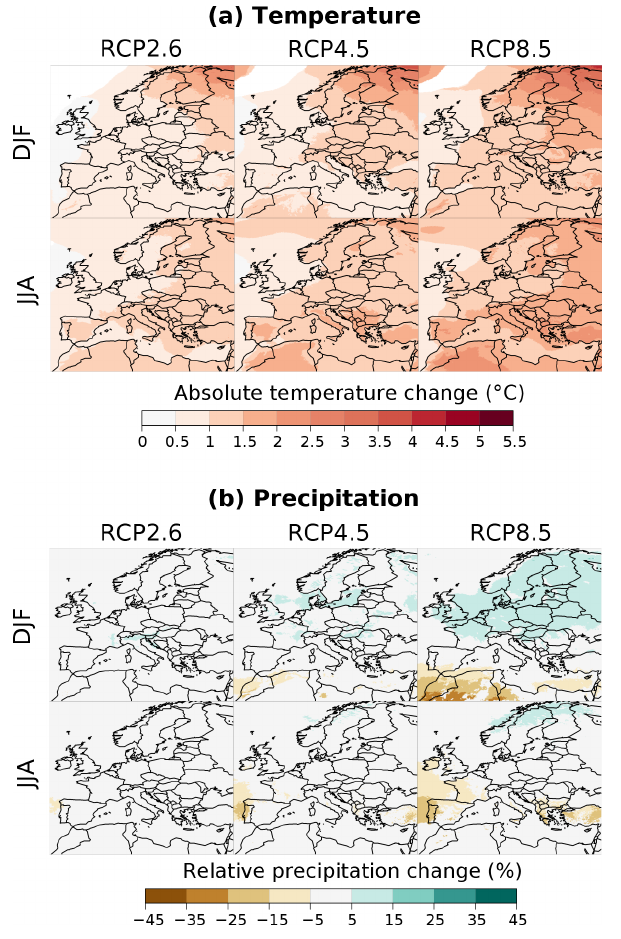
Figure 5. Balanced mean climate change response BM k obtained with the different RCP scenarios at the end of the 21st cen- tury (2071–2099) compared to the period 1981–2010 in winter (DJF) and summer (JJA). (a) Absolute changes in temperature. (b) Relative changes in precipitation. Only areas where the abso- lute response-to-uncertainty ratio is greater than 1 ( | BM k / BU | > 1) are